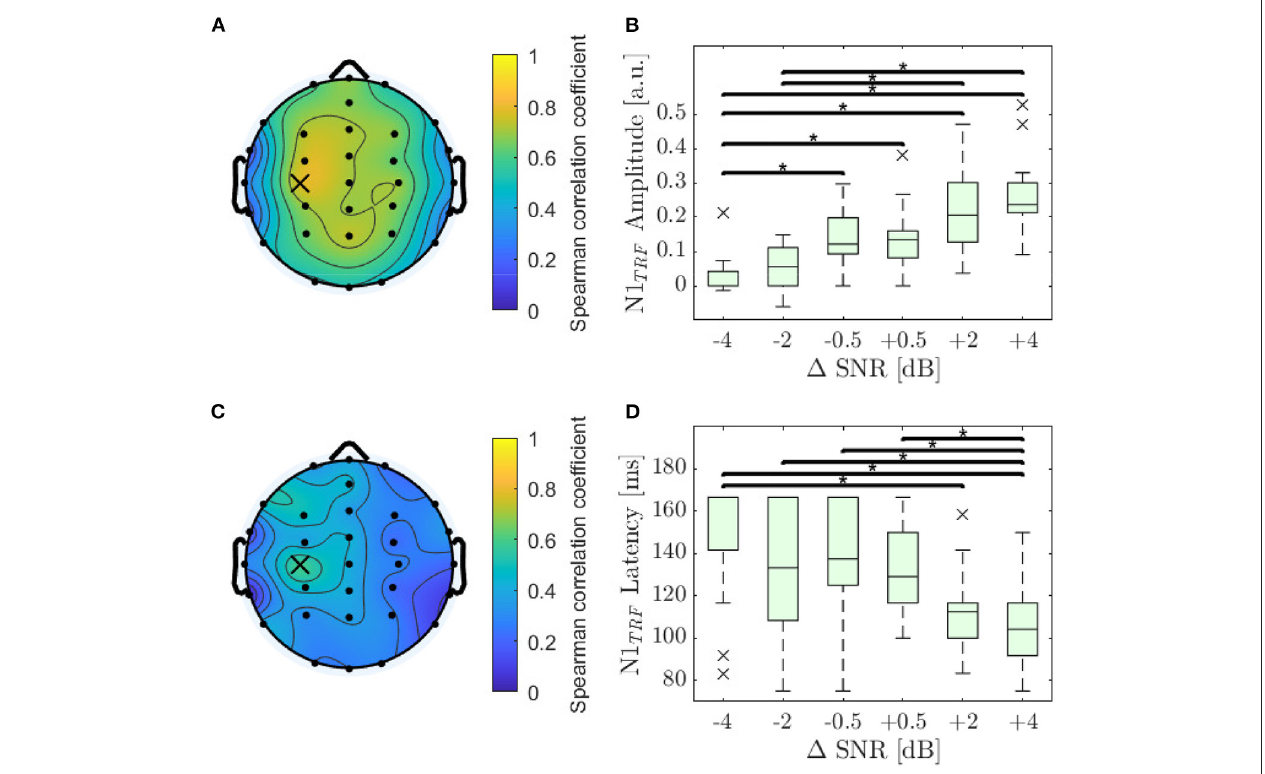
FIGURE 4 | Analysis of the N1 TRF . (A) Distribution of the monotonicity for amplitude of the N1 TRF evaluated by using Spearman’s ρ , reaching its maximum value at electrode C3 ( ρ = 0.78; p < 0.001). (B) Amplitude values for N1 TRF as a function of 1 SNR at electrode C3. Asterisks denote significant differences evaluated by a Dunn-Bunferroni post-hoc test. (C) Distribution of the absolute monotonicity for the N1 TRF latencies evaluated by using Spearman’s ρ , reaching its maximum value at electrode C3 (marked with a cross; ρ = 0.48; p < 0.001). (D) Latencies for N1 TRF as a function of 1 SNR at electrode C3.